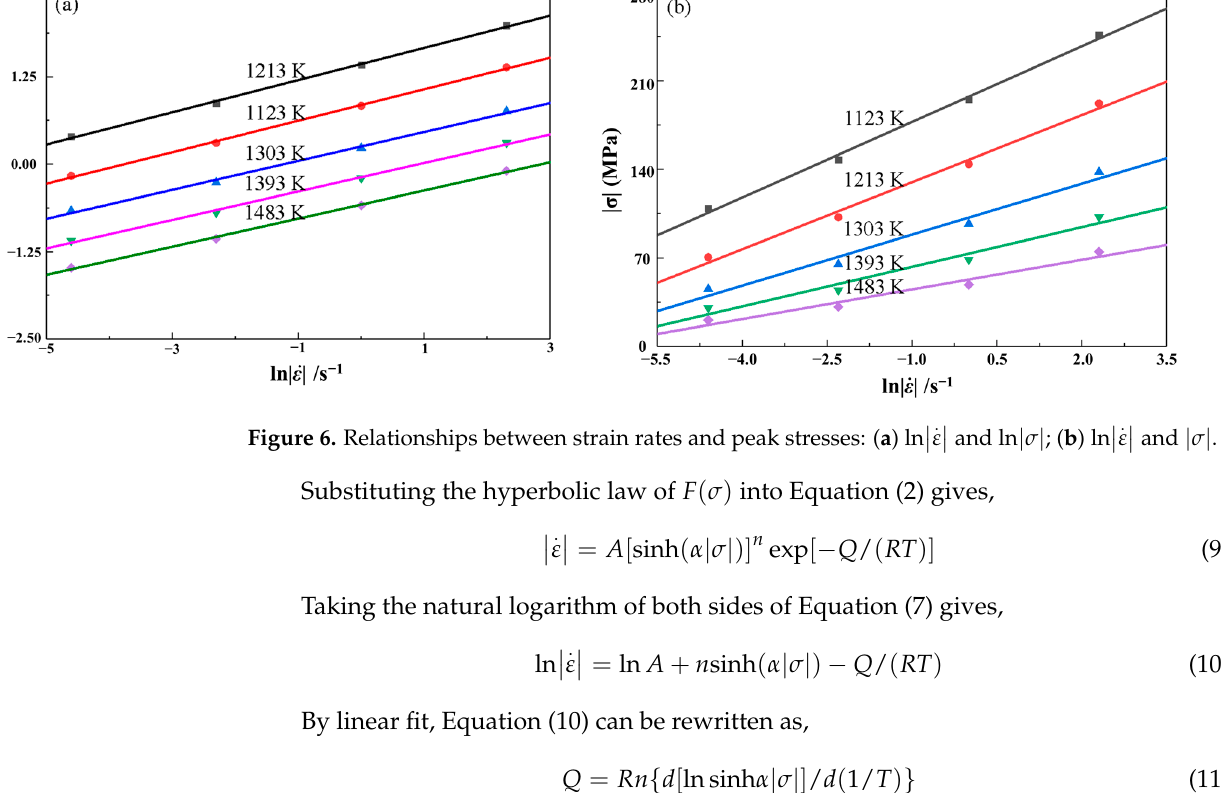
As shown in Figure 7a, the distribution of all points is linear. By a linear fitting with an average error of 0.10, the relationships between ln sinh [ α | σ | ] and 1/ T is linear at different strain rate, and the slopes are approximated the same with each other. The value of Q can be obtained from the slope of ln sinh α | σ | versus 1/ T. The average value of all the slope rates is accepted Q /( RT ), furthermore, the value of Q is obtained as 359.6095 kJ · mol − 1 .